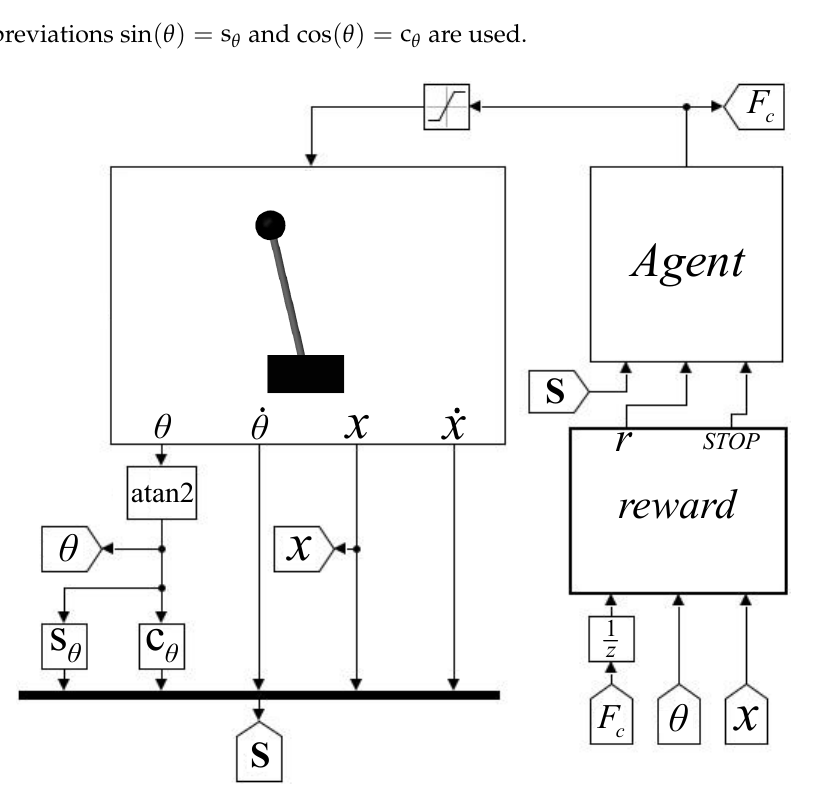
Figure 3. Simulink implementation of the RL